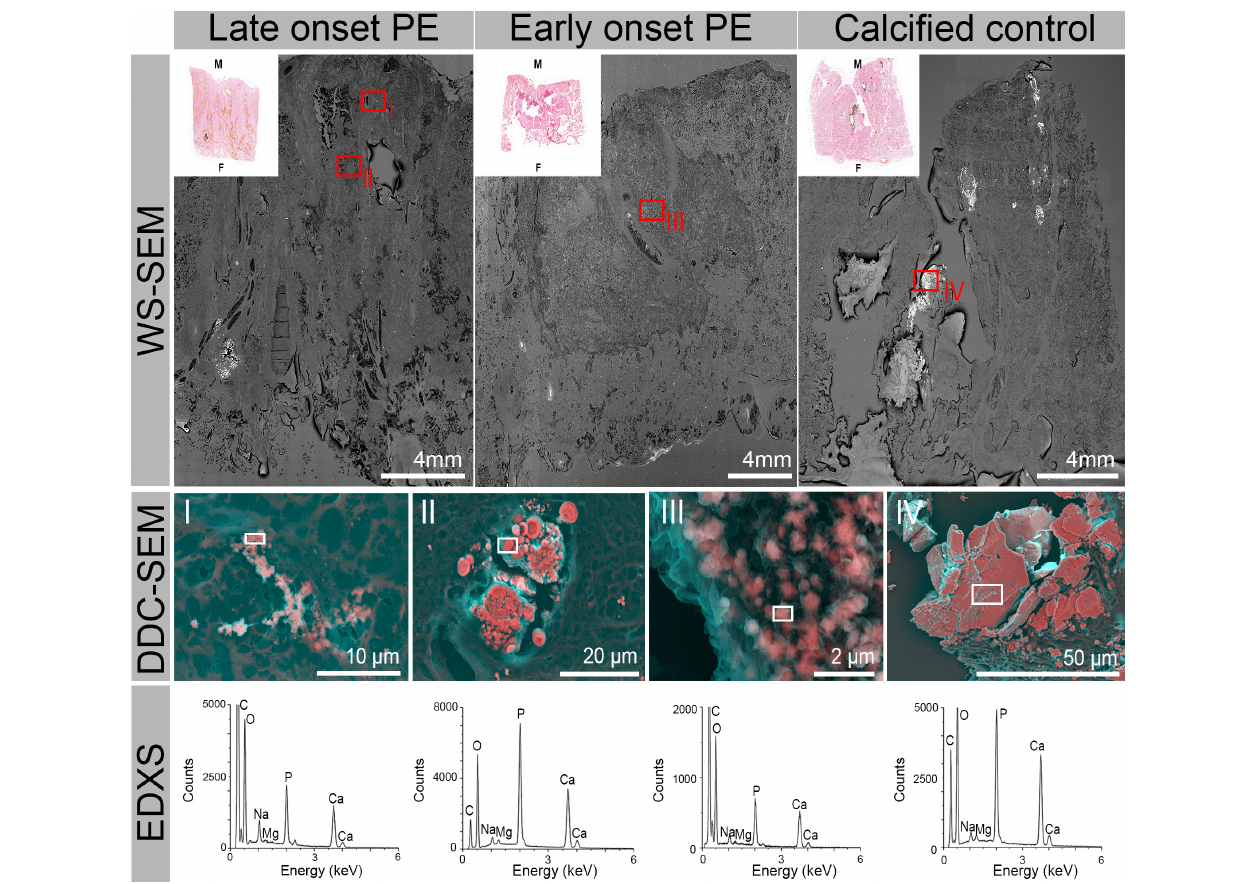
FIGURE 5 | Whole slide scanning electron micrographs (WS-SEM) and corresponding HE histology micrographs from three representative placentae. From left to right: late onset PE, early onset PE and calcified control placenta. High magnification DDC-SEM illustrate the four characteristic subtypes of calcifications observed in the tissue samples: (I) needle like structures, (II) large spherical calcifications formed by concentric rings, (III) small spherical rough particles, (IV) large block calcifications of no specific internal structure (for higher detail images see also Supplementary Figure 1 ). Their localization is indicated by red boxes on the WS-SEM images. Energy-dispersive X-ray spectra (EDXS) indicate comparable composition of the particles (location of analysis indicated by white boxes), which mainly consist of Ca, P, and O with traces of Mg. Spectra obtained from surrounding non-calcified tissue support this statement (see Supplementary Figure 2 ). Carbon is part of the sample support and the tissue and hence also present in variable